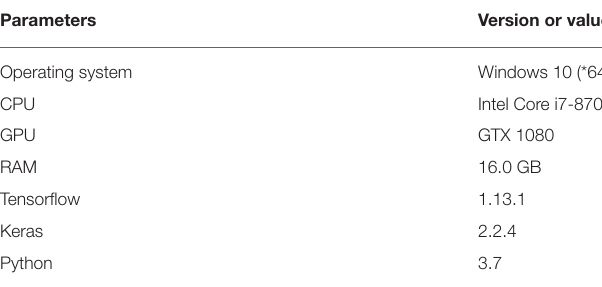
TABLE 1 | Configuration of test